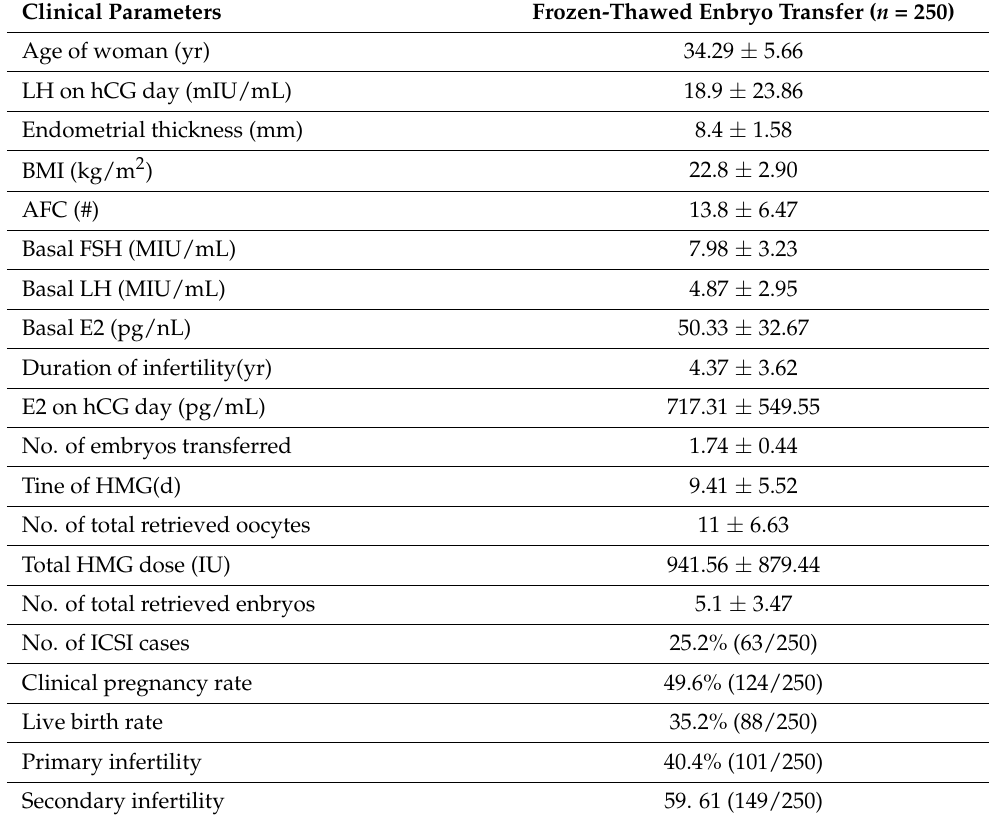
Table 1. Demographics, patient characteristics, and clinical outcomes. Clinical